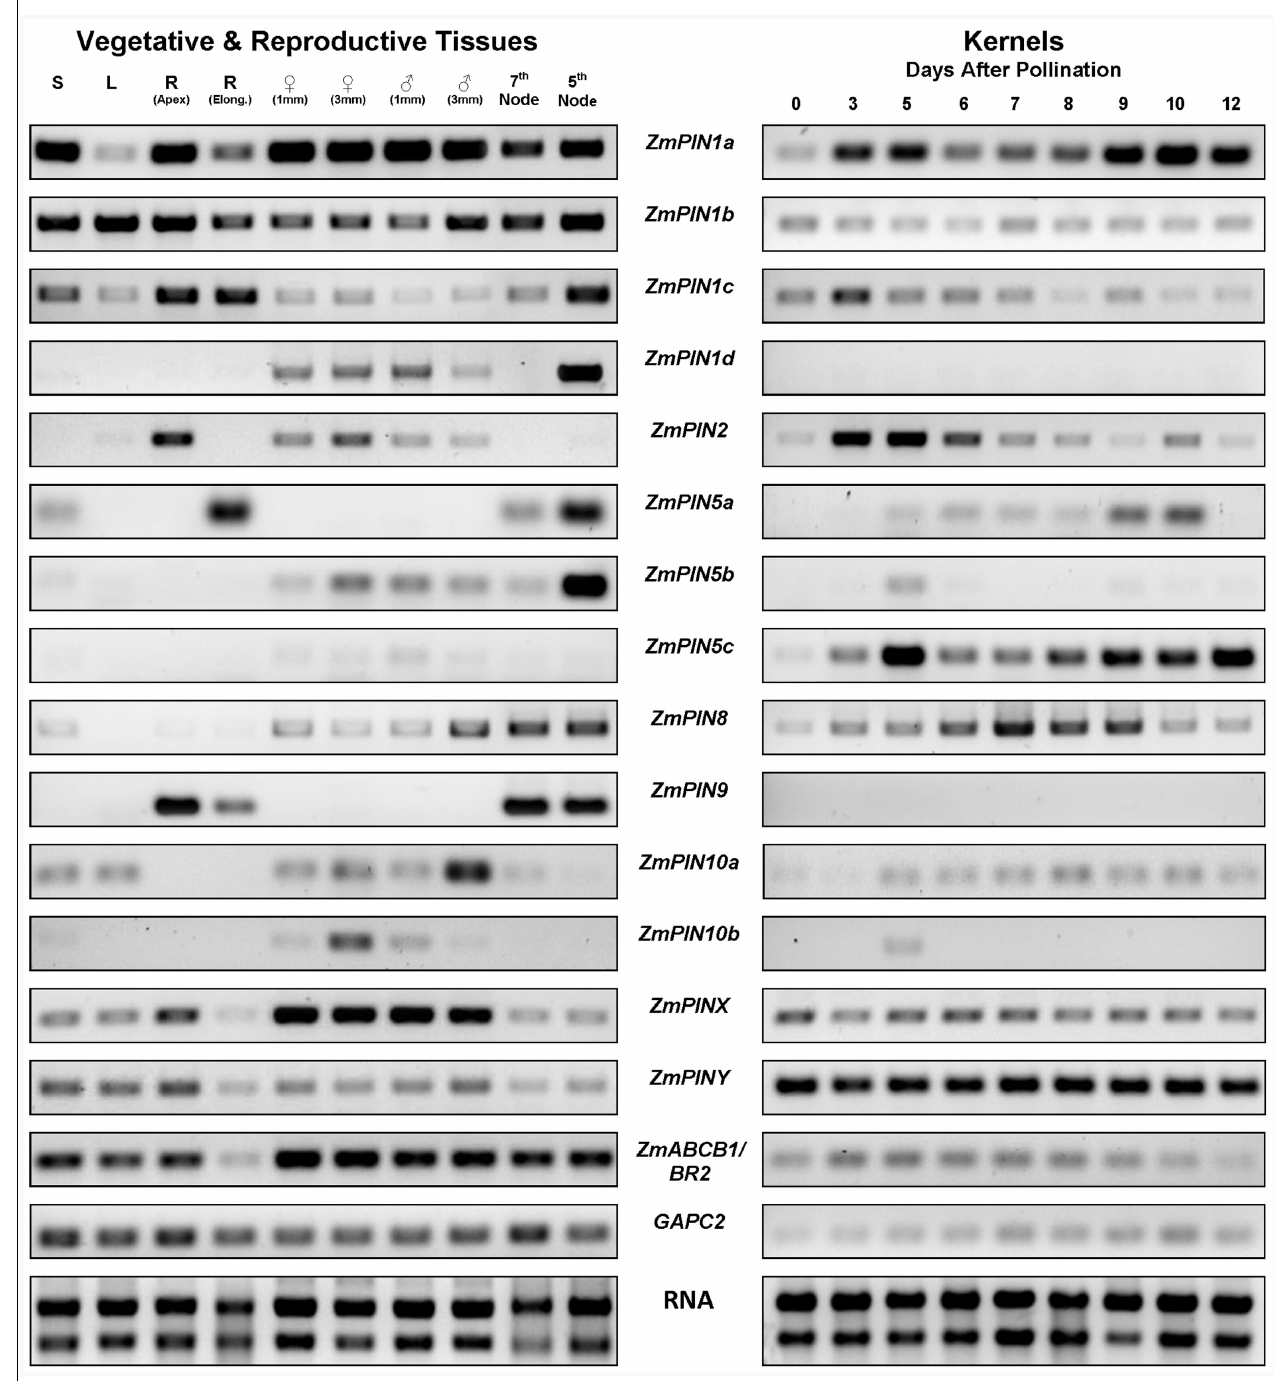
number of amplification cycles for each gene). ZmPIN1a , ZmPIN1b , and ZmPIN1c are expressed ubiquitously and differentially up-regulated in the tissues. ZmPIN1d is expressed in tassels, ears, and in the 5th node of adult plants. ZmPIN2 is expressed in root apex (R), in male and female inflorescences and during maize kernel development. ZmPIN5a is expressed in seedlings (S), in the root elongation/mature zone, in nodes and in the young seed till 10 DAP. ZmPIN5b is expressed in male and female inflorescences,